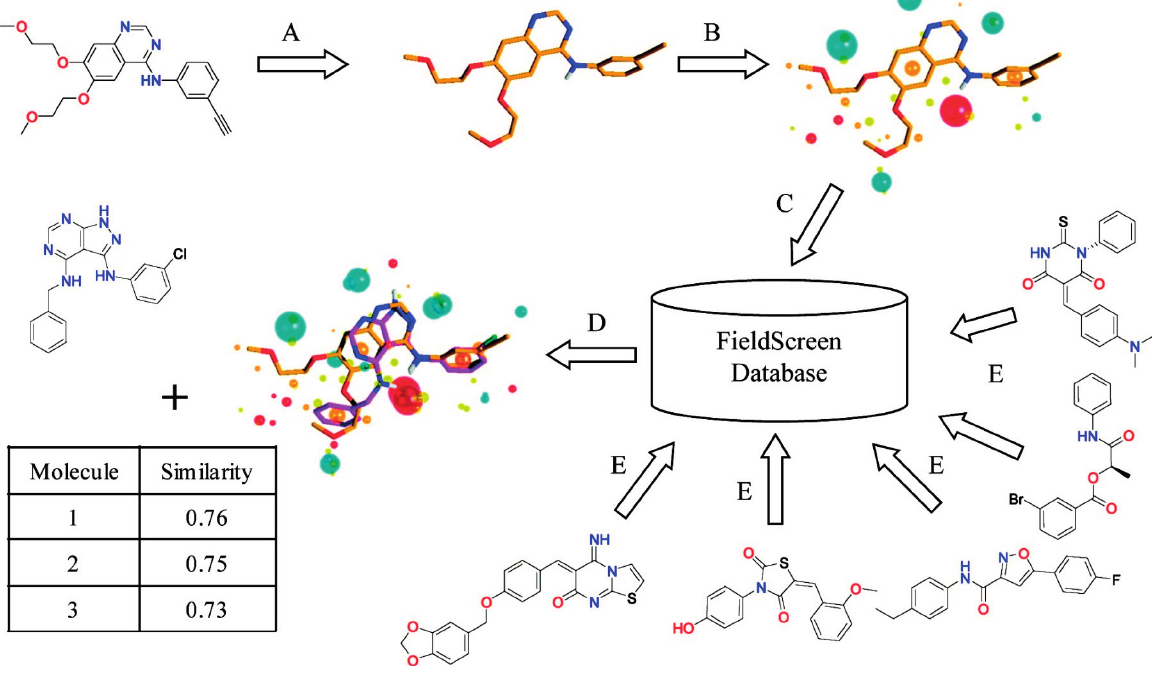
Figure 3. Schematic view of Blaze, which was previously called Fieldscreen. ( A ) A known active molecule is selected as a query; ( B ) Field points generation; ( C ) Searching a ligand database; ( D ) Rank compounds in the database by the similarity score. Reprinted with permission from [13]. Copyright (2015) American Chemical